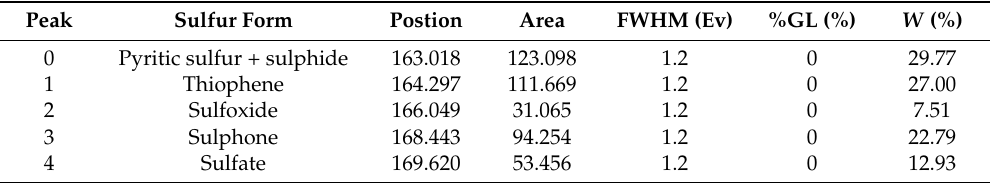
Figure 8. S 2p spectrum of the XF oxidized coal sample. Table 2. The S 2p spectrum analysis of the XF original coal sample.